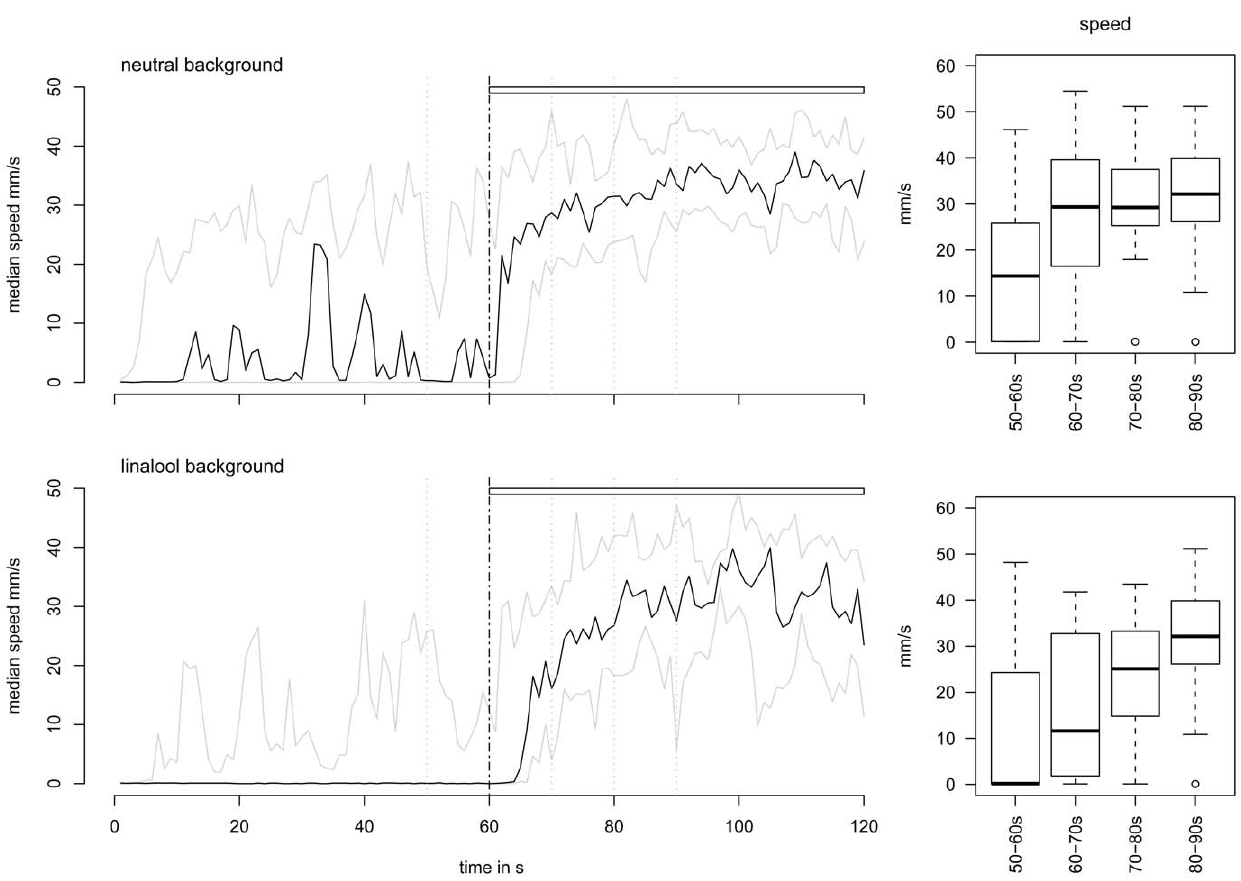
Figure 6. Lin delays the onset of the PWR. On the left: time plots of speed changes during two-phase experiments (median in black; first and third quartiles in grey). Upper horizontal bars show pheromone presentations. The vertical grey dashed lines delimit the four 10-s time windows chosen to calculate and compare the median speeds presented in the corresponding box plots (Right) prior to and after pheromone application in a neutral ( N =22) vs. a Lin background ( N =18). Box plot legends as in Figure 3.